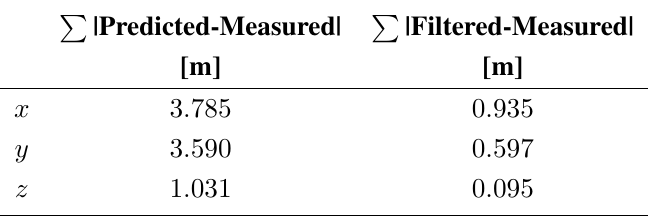
Table 1. Sum of differences between predicted/filtered and measured values. (cid:80) |Predicted-Measured|